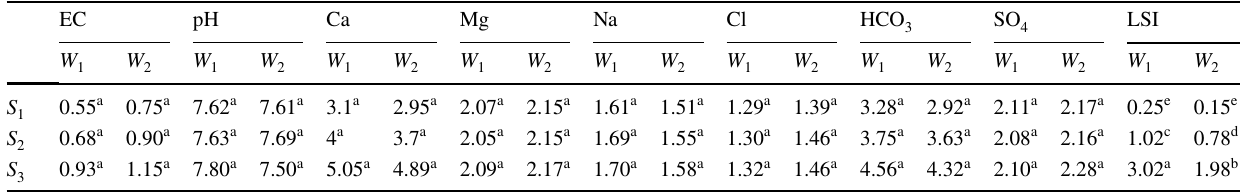
Table 4 The interaction effects of water irrigation and salinity water treatments on chemical parameters of irrigation water